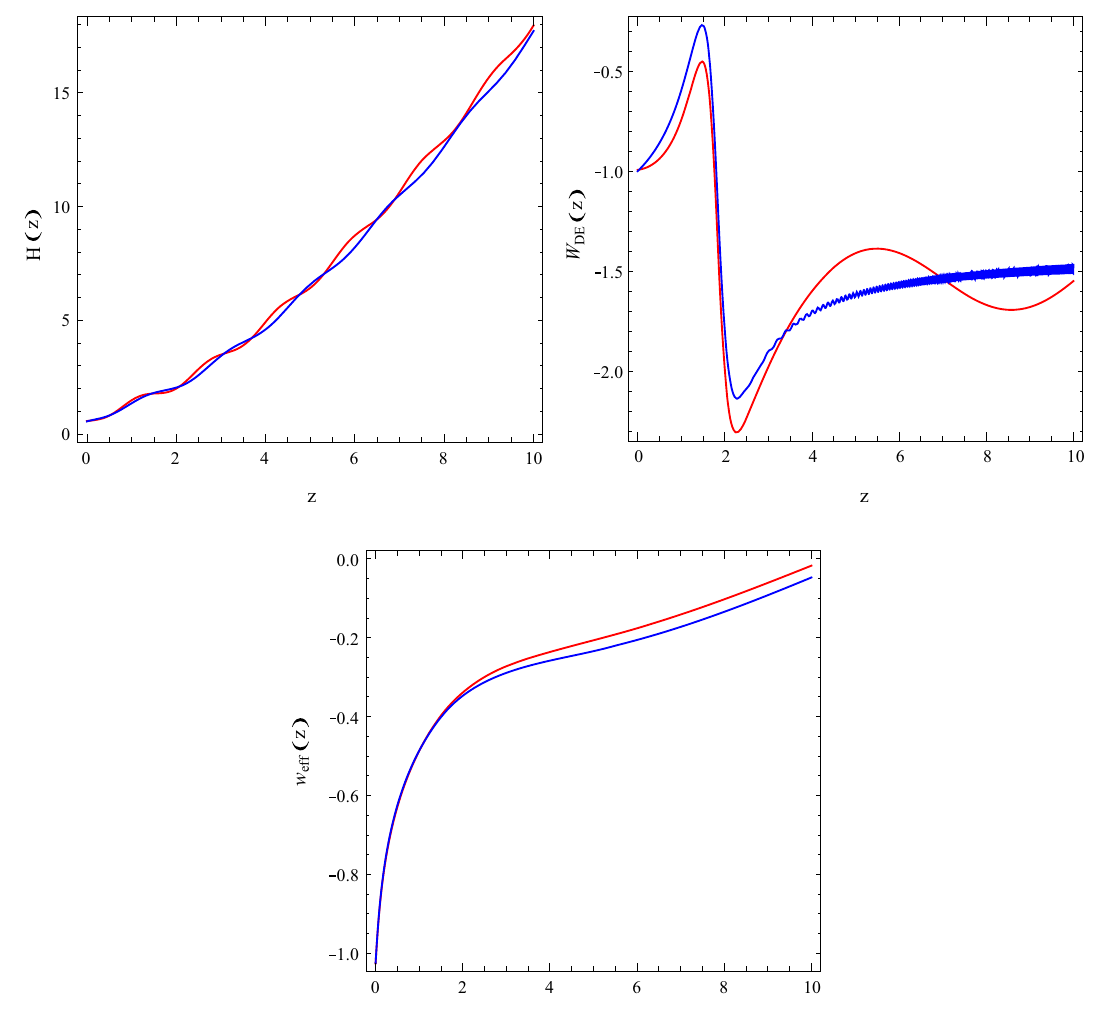
sional matter, while the blue curves correspond to the mimetic f ( R , T ) model in the presence of the non-collisional matter (dust) for the model √ Q ( z ) = 2 z + 5